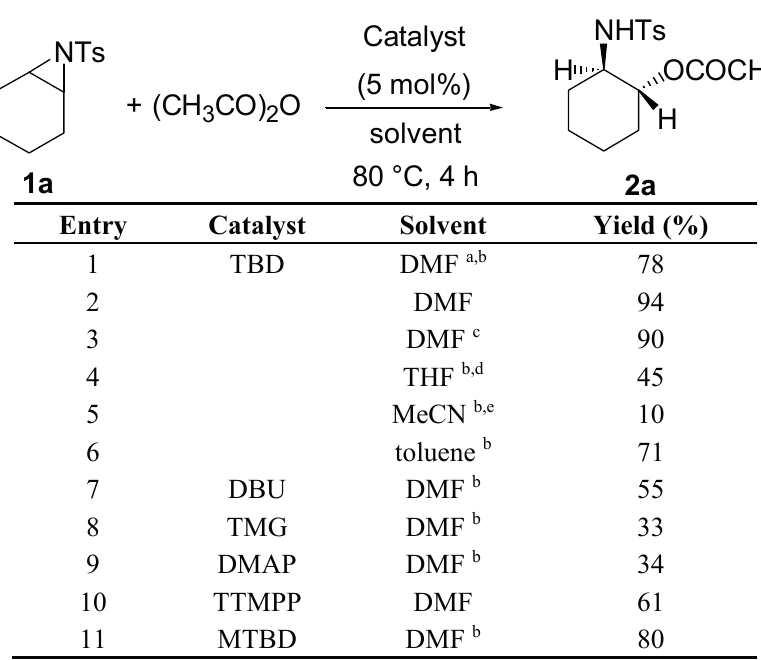
Table 1. Optimization of the reaction